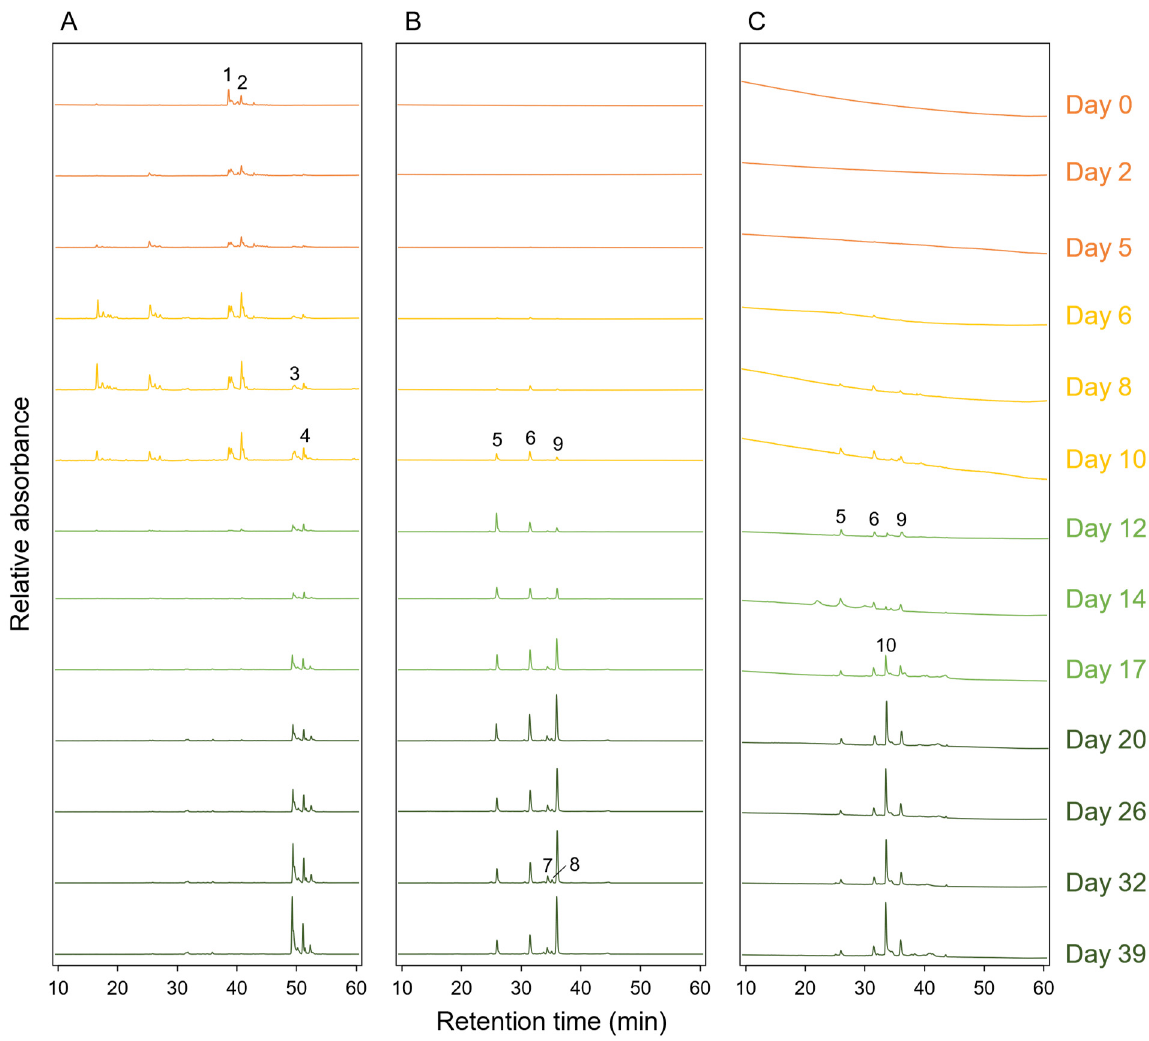
Figure 5. Reverse-phase HPLC elution profiles of pigments extracted from C. aurantiacus cells collected at the 13 sampling dates. Elution profiles when absorbance was measured at 490 nm, 667 nm, and 768 nm are shown in panels ( A – C ), respectively. The chromatograms in the first and second lag phases (days 0 to 10) were magnified five times for the clarity. The colors in elution profiles correspond to sampling dates: orange, days 0–5; yellow, days 6–10; light green, days 12–17; dark green, days 20–39. Putative assignments of peaks are as follows: peak 1, 4-keto- γ -carotene; peak 2, echinenone; peak 3, γ -carotene; peak 4, β -carotene; peaks 5, 6, 7, and 9, BChl c ; peak 8, BChl d ; peak 10, BChl a .